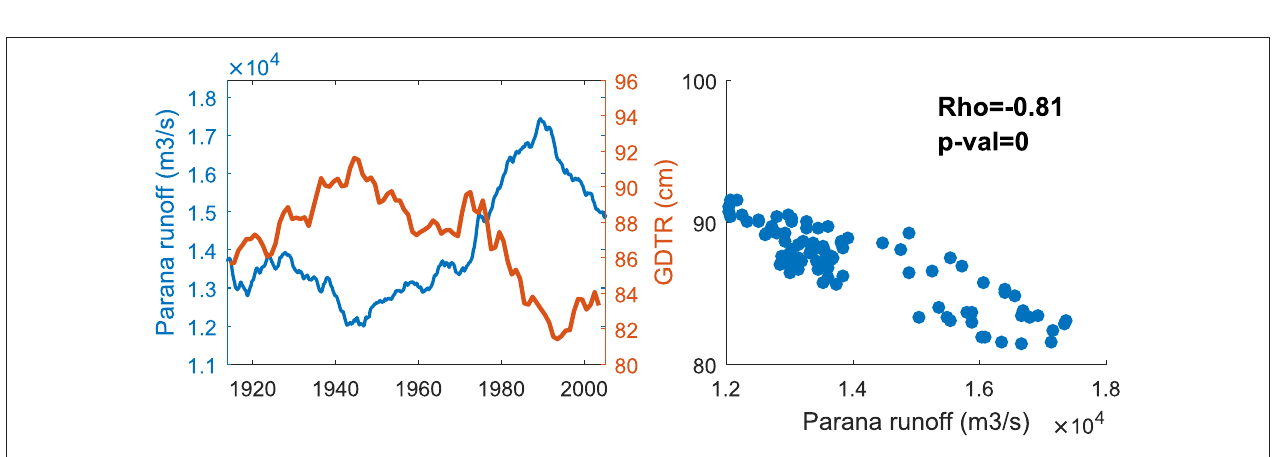
FIGURE 8 | Comparison of the MSL (19 y running average) and the GDTR of (A) Buenos Aires and (C) Mar del Plata; scatter MSL and GDTR of (B) Buenos Aires and (D) Mar del Plata.